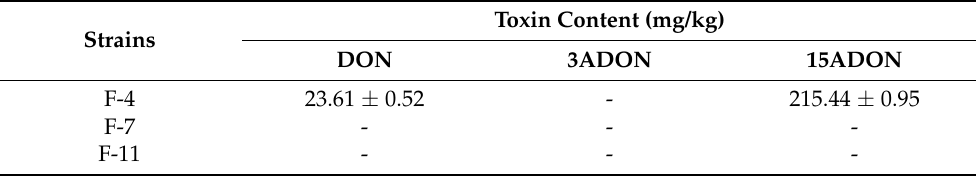
Table 1. Determination results of DON and its derivatives produced by Fusarium strains. Toxin Content (mg/kg) Strains DON 3ADON 15ADON F-4 23.61 ± 0.52 - 215.44 ± 0.95 F-11 - - -